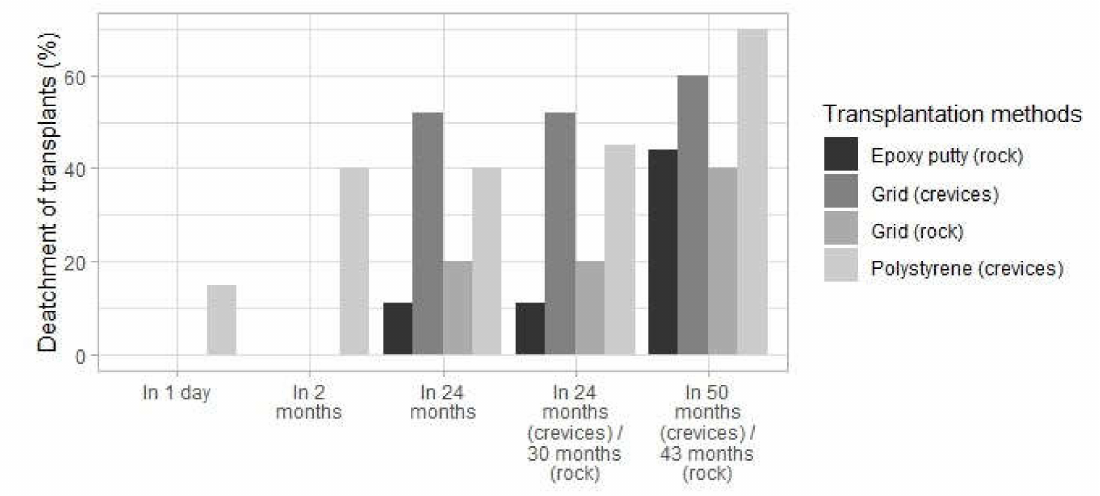
Figure 4. Detachment of C. rubrum transplants (expressed in percentage) from the beginning of the experiments to November 2021 for each transplantation method at Gallinara